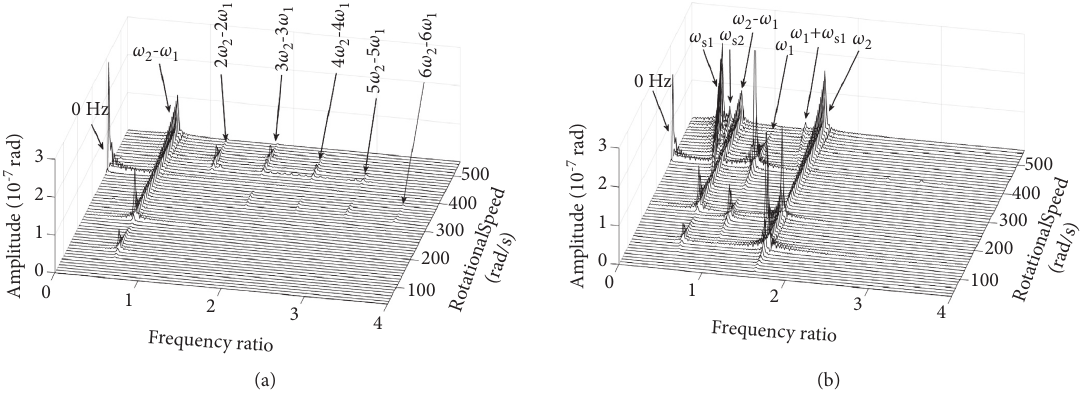
Figure 9: Waterfall spectrum plots for the torsional vibration of disk 4. (a) Level flight. (b) Hovering